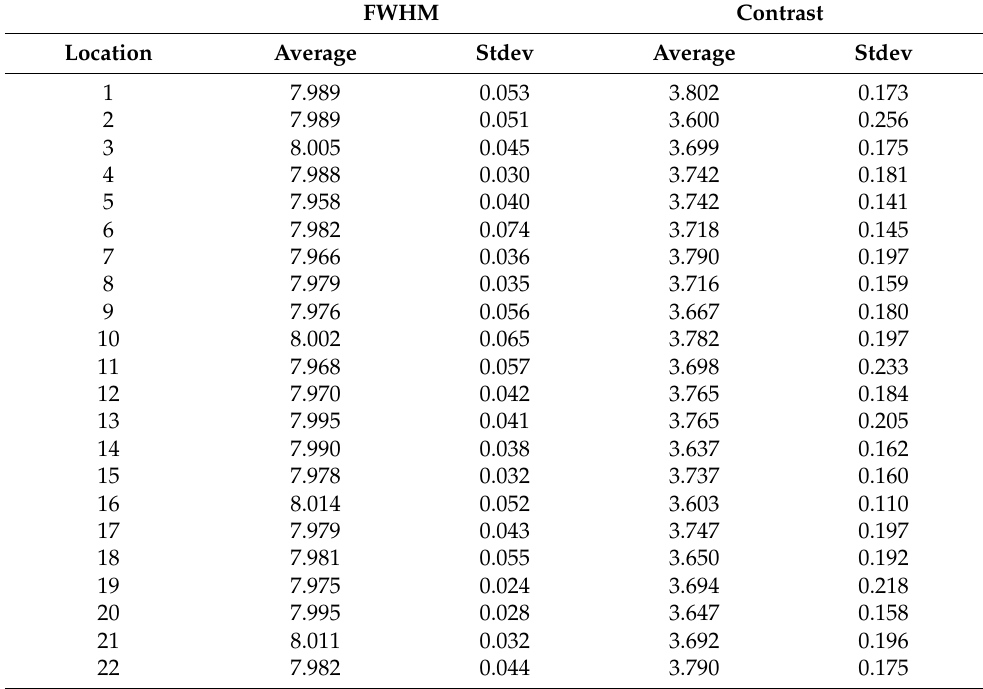
Table 2. A summary of the average and the standard deviation of FWHM and contrast parameter for all studied